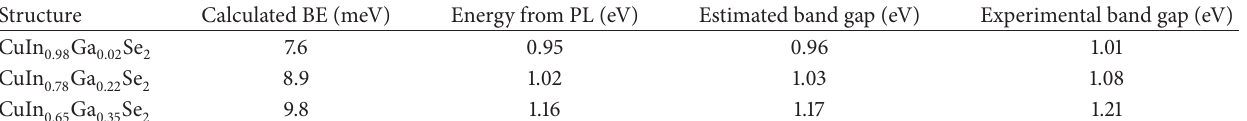
Table 1: Increase in calculated and experimental band-gap energy with increase in gallium content for Cu(In 1−𝑥 Ga 𝑥 )Se Structure Calculated BE (meV) Energy from PL (eV) Estimated band gap (eV)